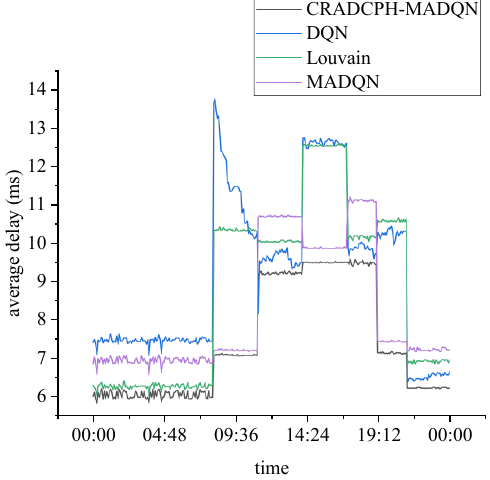
Figure 3. Average delay.